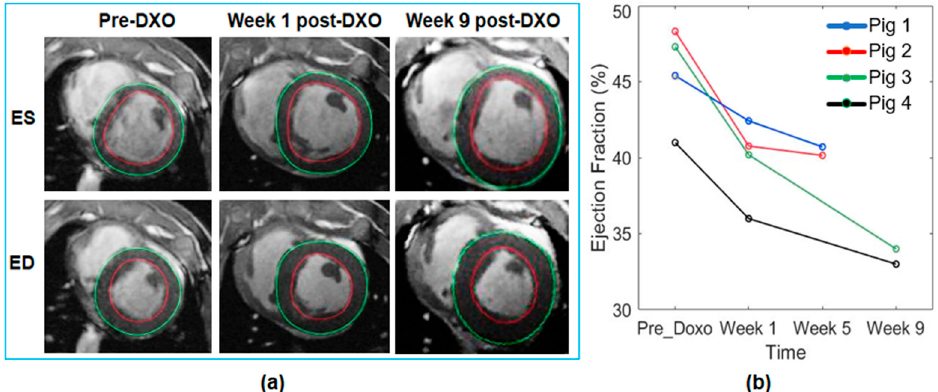
Figure 5. Characterization of the LV function through analysis of Cine MR images: ( a ) example of short-axis slice at mid-heart level, representing the end-systole and end-diastole phases during the cardiac cycle at different time points pre-DOX and post-DOX in pig #3 (ED = end-diastole, ES = end- systole); and ( b ) temporal evolution of the individual EF (%) parameter for each